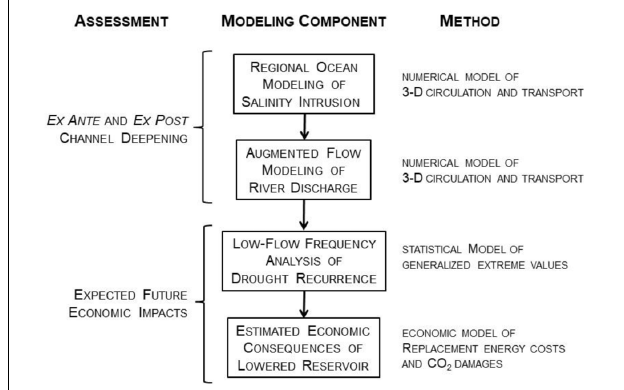
FIGURE 3 | An integrated modeling framework for source-to-sea